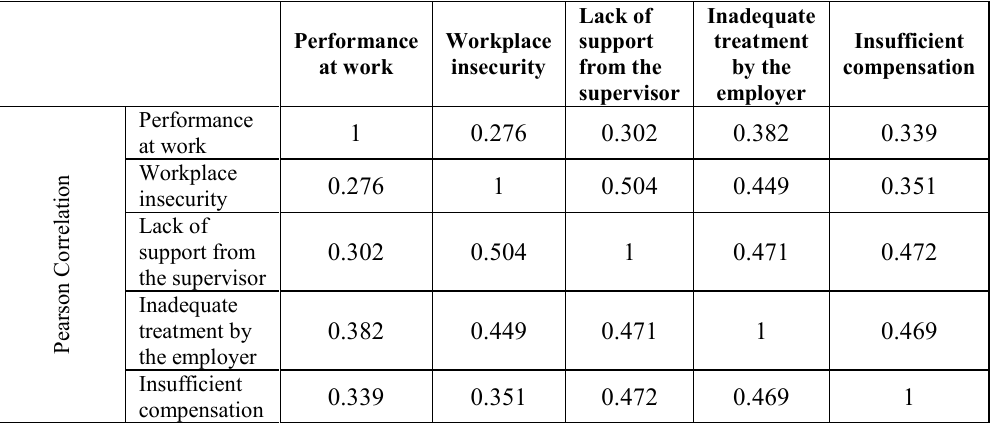
Table 2. Correlation between Performance at Work